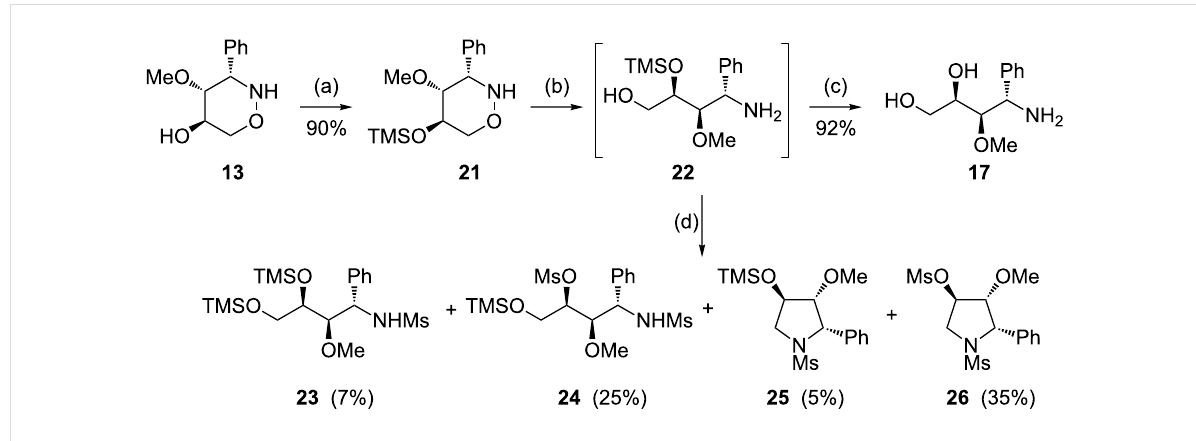
Scheme 7: Attempted synthesis of pyrrolidine derivatives from precursor 13 . (a) TMSCl (1.5 equiv), imidazole, DMAP, CH 2 Cl 2 , rt, overnight; (b) SmI 2 , THF, 1.5 h, rt; (c) CHCl 3 , rt, overnight; (d) MsCl (4 equiv), Et 3 N, CH 2 Cl 2 , rt,